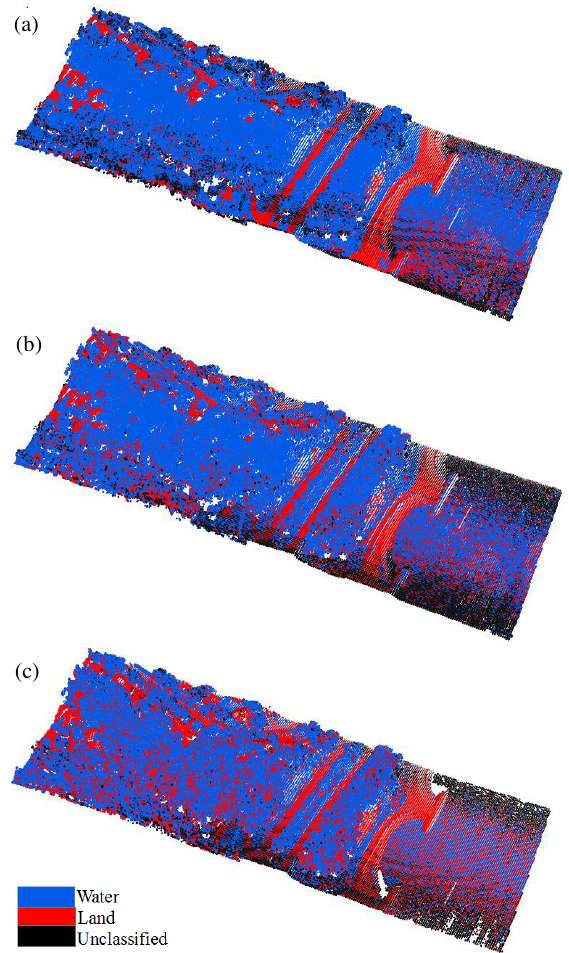
Figure 8. Labelled LiDAR points of Site I from: a) NDFI G-NIR , b) NDFI G-MIR , and c) NDFI